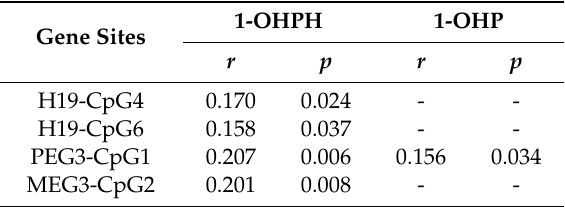
Table 5. The correlation of urinary OH-PAHs and methylation level at individual CpG sites of imprinting genes. 1-OHPH Gene Sites